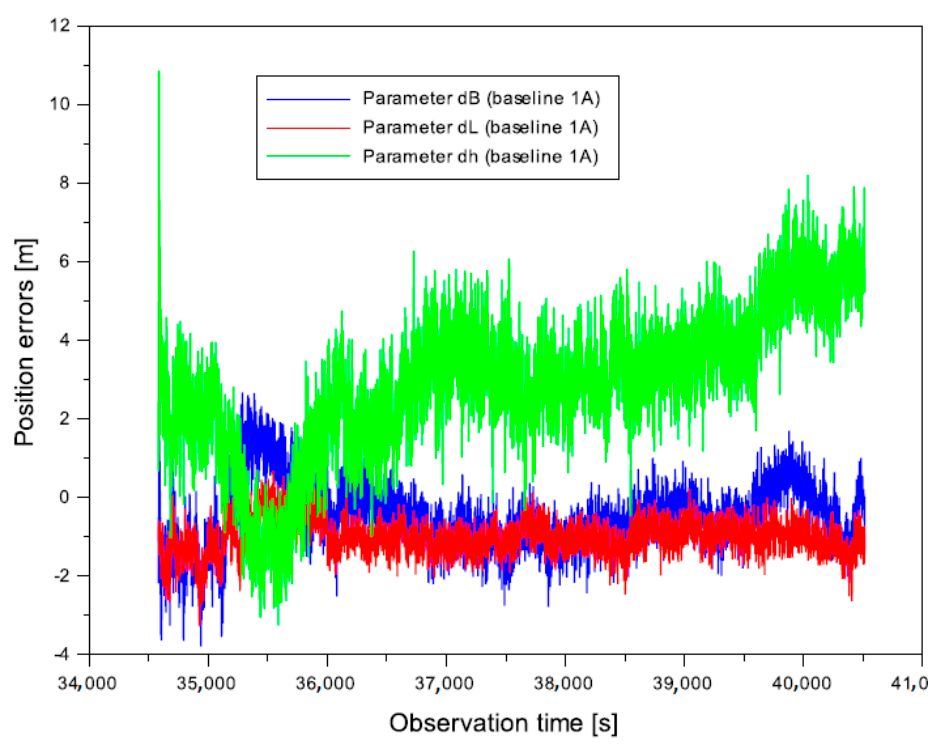
Figure 2. The results of position errors for baseline 1 A .